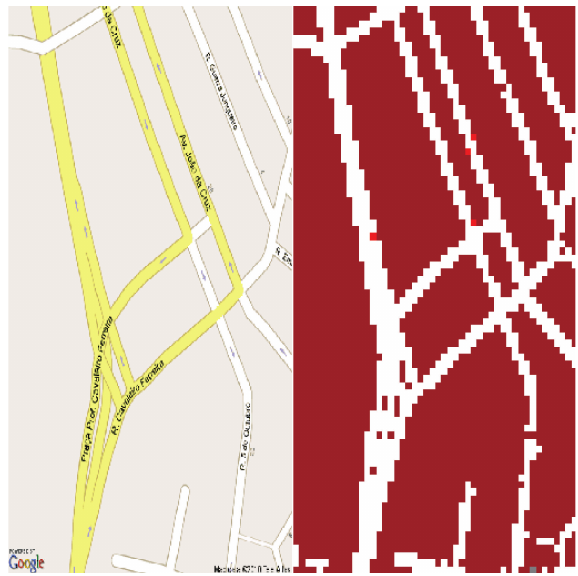
Figure 1: A map and a visual representation of the mined